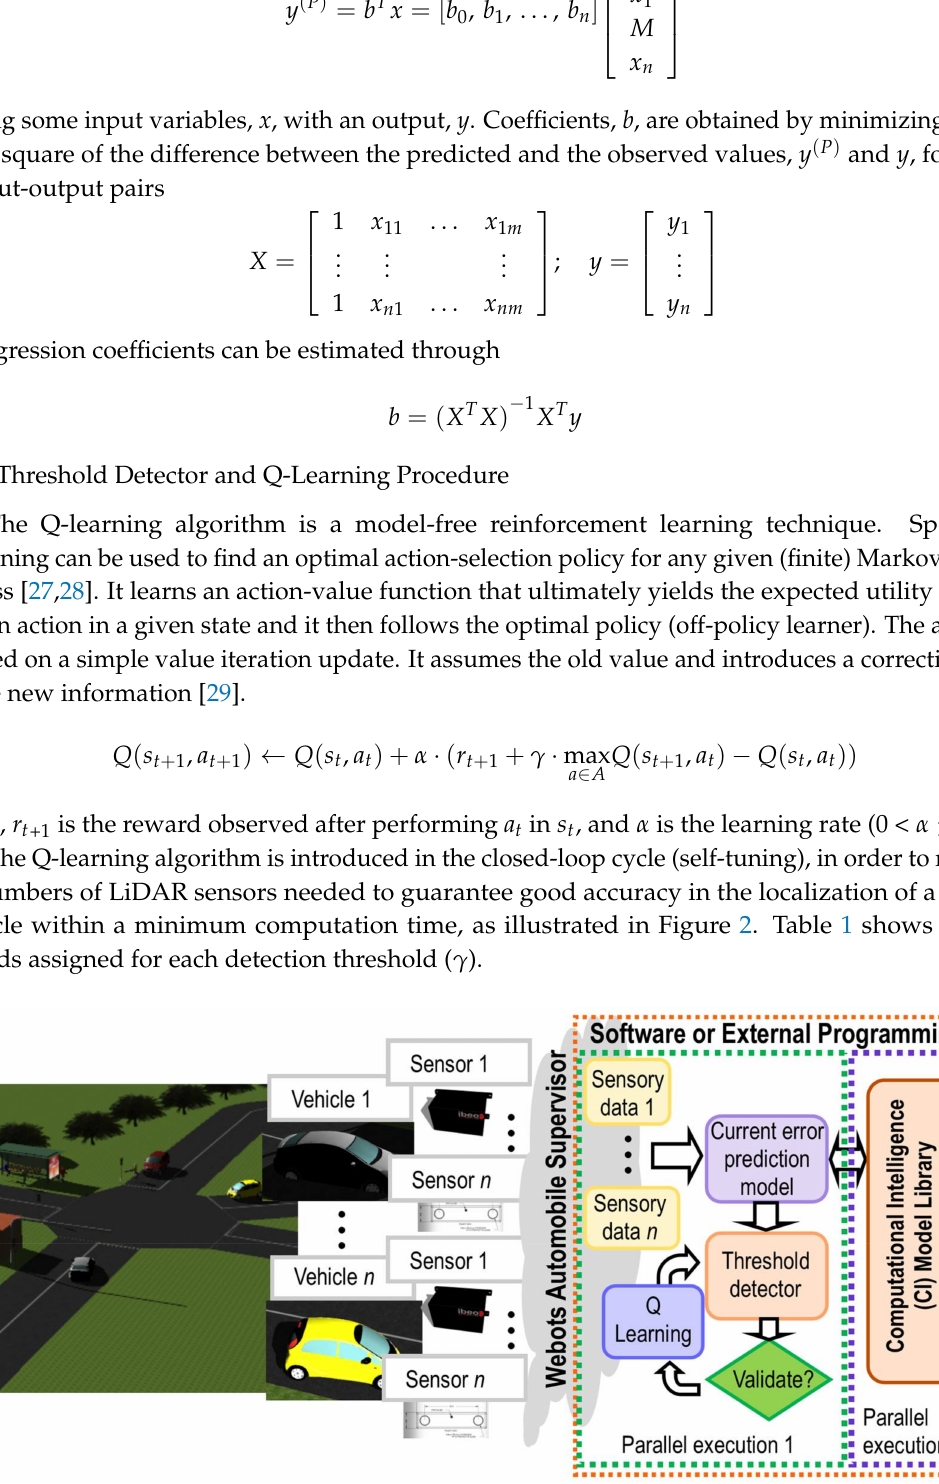
Figure 2. Implementation of self-tuning procedure (knowledge-based learning